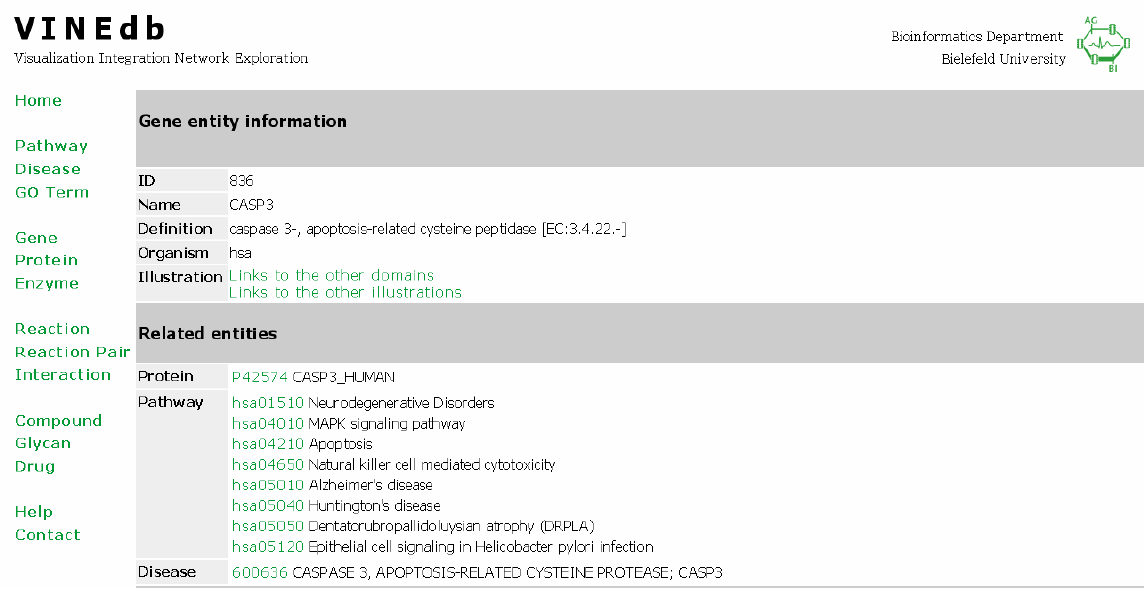
Figure 4: CASP3 gene entity information as shown in VINEdb and its role in disease pathways Alzheimer’s disease (AD) is a neurodegenerative disease that is marked by neuronal death, extra cellular senile plaques (SPs) and intracellular neurofibrillary tangles (NFTs). It has